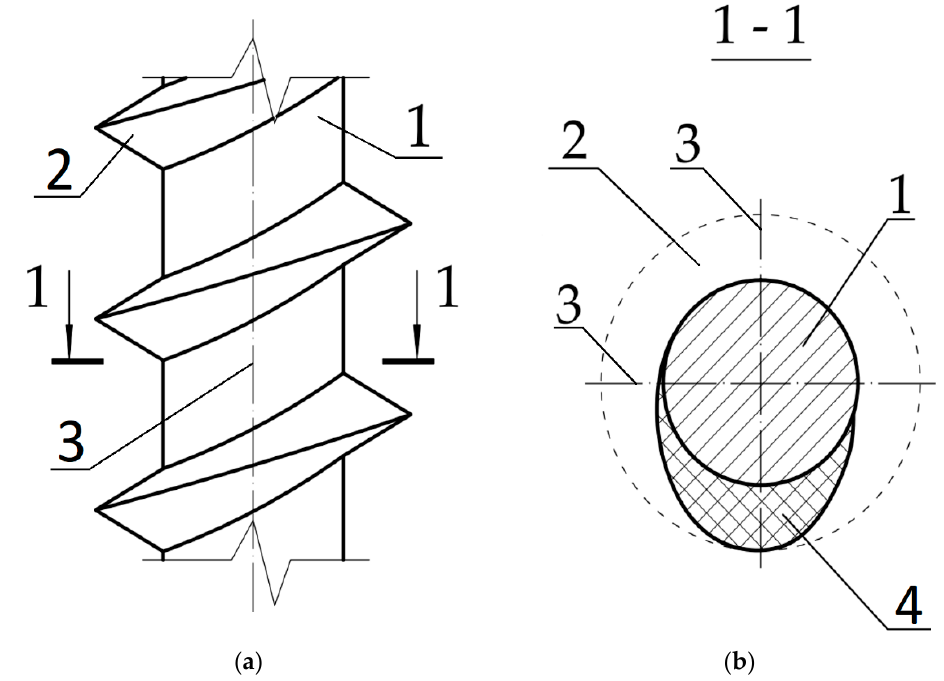
Figure 1. Schematic representation of a helical reinforced concrete pile: ( a )—side view of the pile segment, ( b )—cross-section of the helical reinforced concrete pile, where: 1—pile shaft; 2—thread; 3—central axes; 4—thread trace in the section plane.